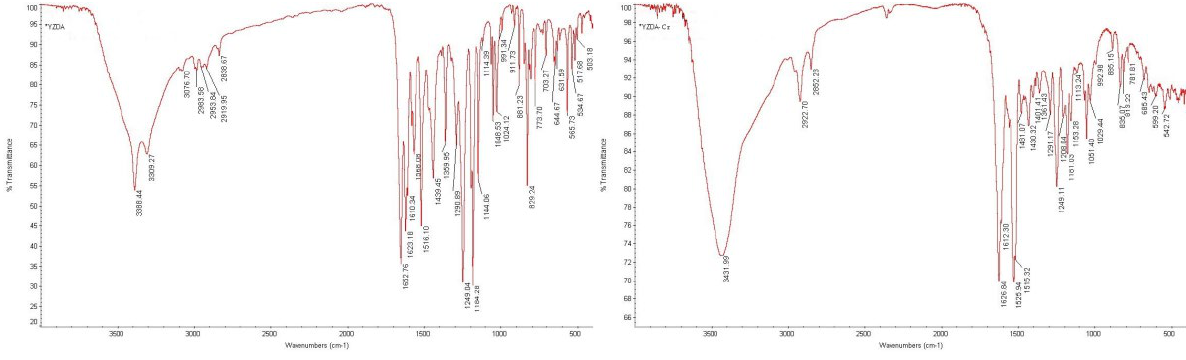
Figure 2. IR spectra of BCA and [CrBCA 3 ]. Table 2. The primary IR spectral data of biochanin A and the chromium complex (cm −1 ). Compound